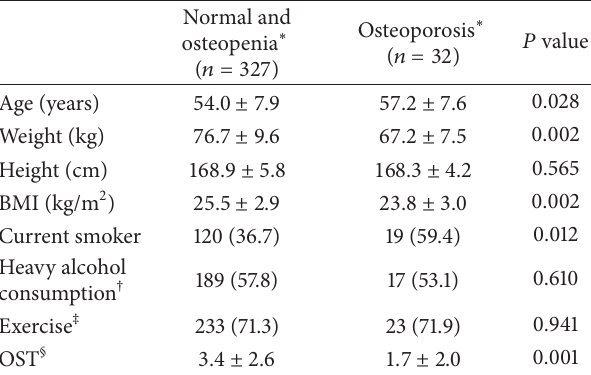
Table 1: Summary of descriptive characteristics of 359 men.